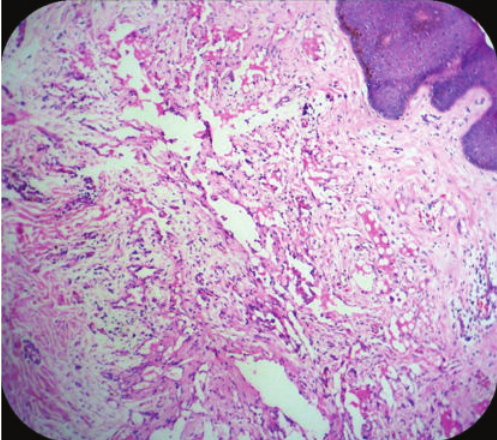
Figure 5: Epidermis with underlying dermis showing thin-walled vascular channels containing RBCs in the lumen (Case 2—H&E × 100).